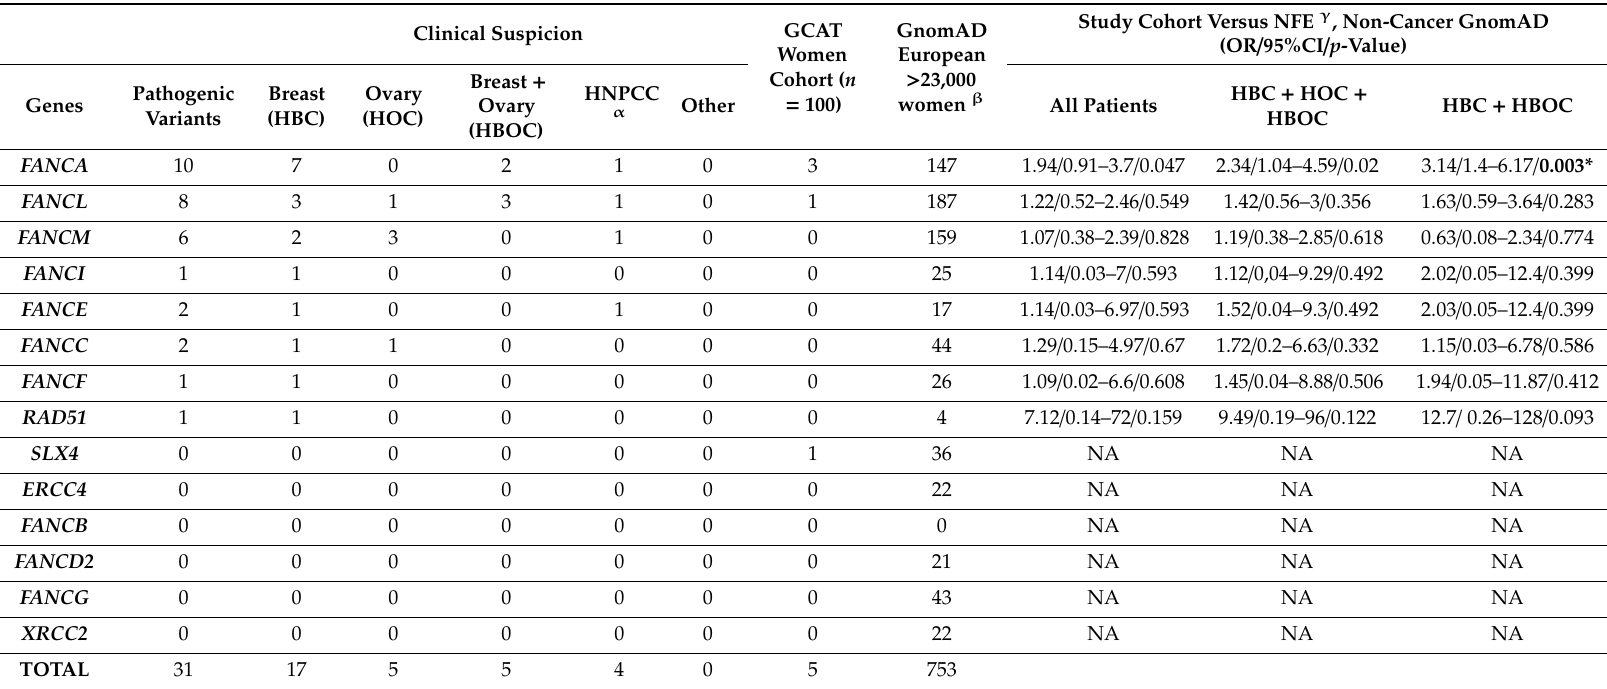
Table 1. Summary of (Likely) Pathogenic Variants in 14 FA genes in the di ff erent clinical groups (only women are